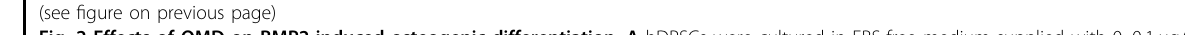
Fig. 2 Effects of OMD on BMP2-induced osteogenic differentiation. A hDPSCs were cultured in FBS-free medium supplied with 0, 0.1 μ g/mL BMP2 and 0, 1, 3 μ g/mL OMD for 24 h. The mRNA levels of SP7 , RUNX2 , OMD , BMP2 , SPARC , and ALPL in hDPSCs were examined by qPCR. Ordinary one-way ANOVA Tukey ’ s multiple comparison test was applied to evaluate statistical signi fi cance. B A full-thickness mandible bone defect of 3 mm in diameter was created with a dental trephine. C Newly formed bones were indicated by three-dimensional (3D) reconstructive images and two- dimensional (2D) images of mandibles. The images of the specimen whose value is closest to the group mean of bone volume/total volume (BV/TV) were presented as the “ representative images ” . Scale bar: 1 mm. D The bone mineral density (BMD), bone volume/total volume (BV/TV), trabecular bone number (Tb.N), and trabecular bone space (Tb.Sp) of the mandible defects were quantitated ( n = 5). Brown-Forsythe or Welch ’ s ANOVA test with Games-Howell ’ s test for multiple comparisons. The sample power of BMD, BV/TV, Tb.N and Tb.Sp quantitated by software GPower 3.1 was 1.0000000, 1.0000000, 1.0000000 and 0.9873885 respectively. Data were presented as mean ± SD. E H&E staining (Scale bar: 0.5 mm), Masson ’ s trichrome staining (Scale bar: 200 μ m) and immunohistochemical staining of Osteocalcin (OCN) (Scale bar: 200 μ m) for bone tissue